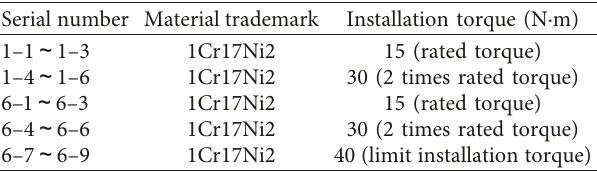
Figure 6: Inspection photos.